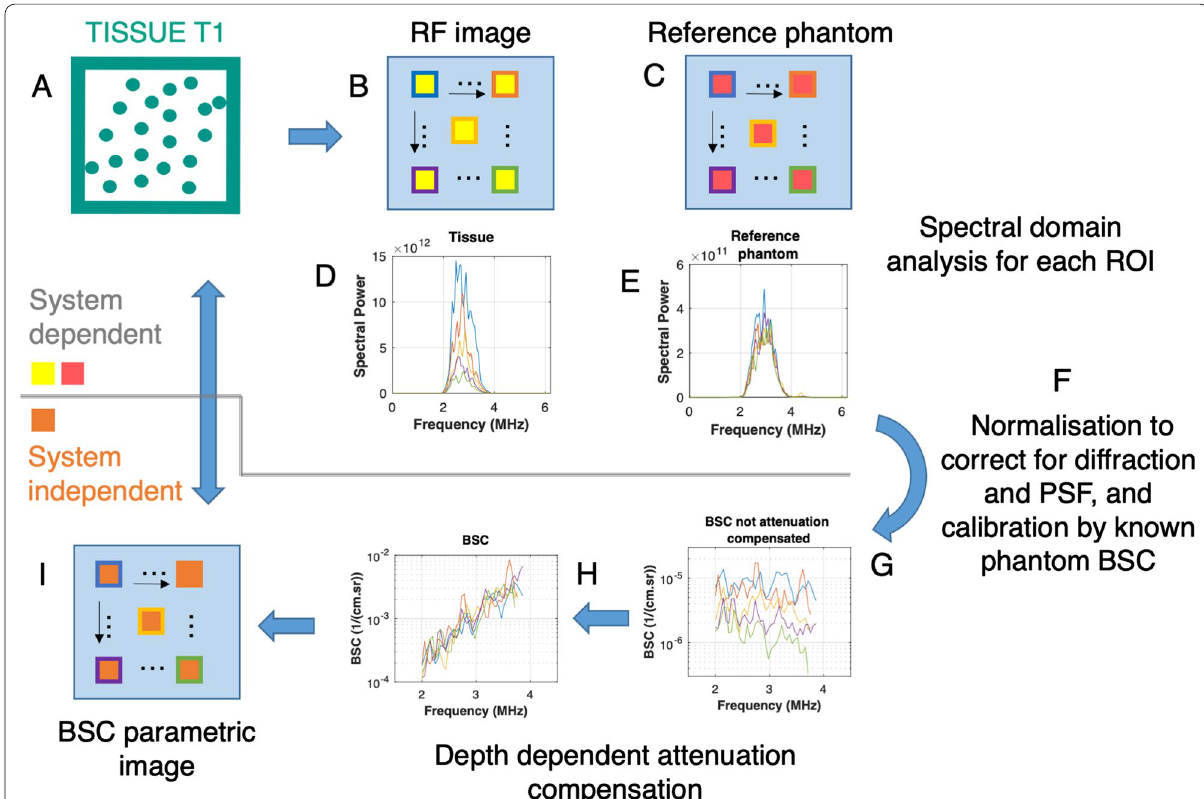
Fig. 15 Block diagram describing processing steps required to compute the backscatter coefficient (BSC). a A biological tissue, containing ultrasound scatterers distributed in space, is interrogated by an ultrasound wave. b The interaction of the ultrasound wave with the tissue produces a backscattered RF image discretized into rectangular measurement windows. c Using the same ultrasound system, a reference RF image is taken on a reference phantom with a known BSC, and discretized rectangular measurement windows are distributed at the same depth and lateral positions as in the case of the tissue image. d, e At every location of a measurement window, power spectra are computed for both images. f To eliminate effects of the system point spread function (PSF) and beam diffraction (which are system dependent and not tissue dependent), a spectral ratio is computed at each location and calibrated by the known BSC of the reference phantom. g At this stage, the tissue BSC is still affected by total attenuation, which needs to be removed. h Depth-dependent attenuation is removed for each measurement window location, which yields a BSC parametric image in i that is system independent. Averaging over multiple acquisitions with different probe positions and/or orientations is practically required to improve